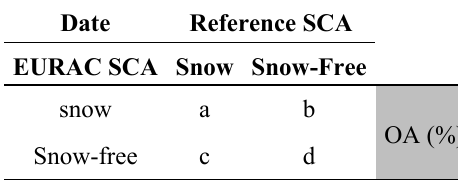
Table 1. Example of confusion matrix used in the validation